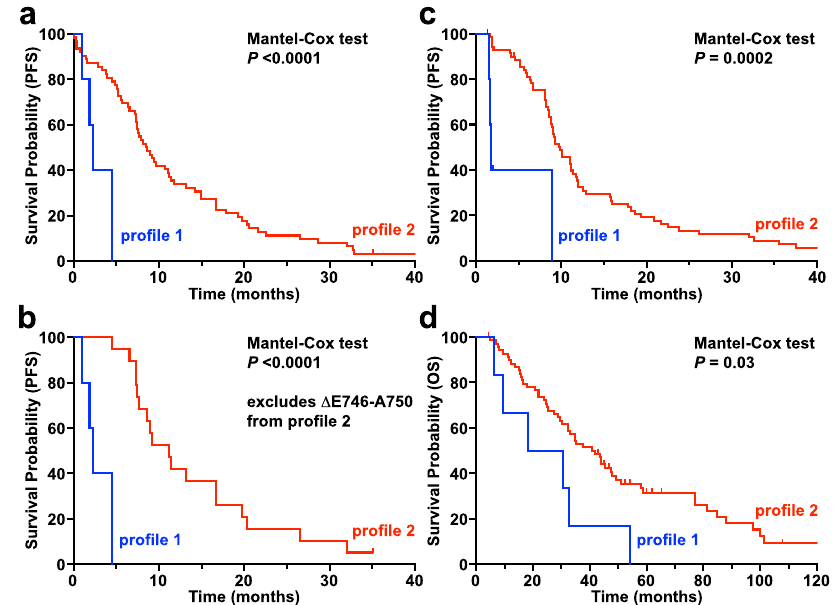
Fig. 7 | Differential survival of erlotinib-treated pro fi le 1 and pro fi le 2 NSCLC patients. Data for survival outcomes on erlotinib treatment were obtained from the GENIE+ database 54 ( a , b ) and from an institutional cohort ( c , d ) as described in the main textfor patients with pro fi le 1 (blue) or pro fi le 2 (red) exon 19 mutations. a UsingGENIE+data,apro fi le1mutationpredictsasigni fi cantlyshortermedianPFS (2.3 months) than a pro fi le 2 mutation (8.5 months) on erlotinib ( P <0.0001). We also performed the same analysis excluding the common Δ E746-A750 deletion, since we know this is erlotinib sensitive, and the prediction still holds ( b ), where a pro fi le 1 mutation predicts median PFS of 2.3 months and pro fi le 2 mutation 11.2 months ( P <0.0001). Predicted pro fi le 1 mutations in the GENIE+ dataset were restricted to: Δ L747-A750InsP (4 patients) plus Δ E746-L747InsIP (1 patient). Pre- dictedpro fi le2mutationswererestrictedto: Δ E746-A750(43), Δ L747-P753InsS(5), Δ L747-T751(3), Δ E746-S752InsV(3), Δ S752-I759(2), Δ L747-S752(2), Δ E746-S752InsI (1), Δ E746-T751InsA (1), Δ L747-T751InsP (1), and Δ E746-T751InsIP (1). c Similarly,